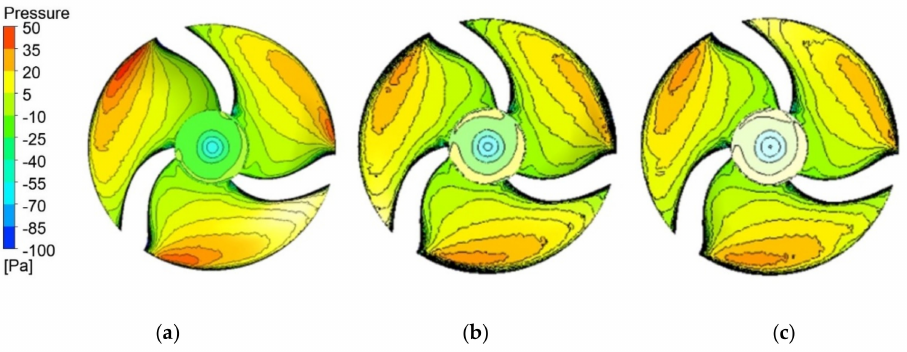
Figure 9. Pressure distribution on the pressure surface: ( a ) Case-Basic, ( b ) Case-10, and ( c )